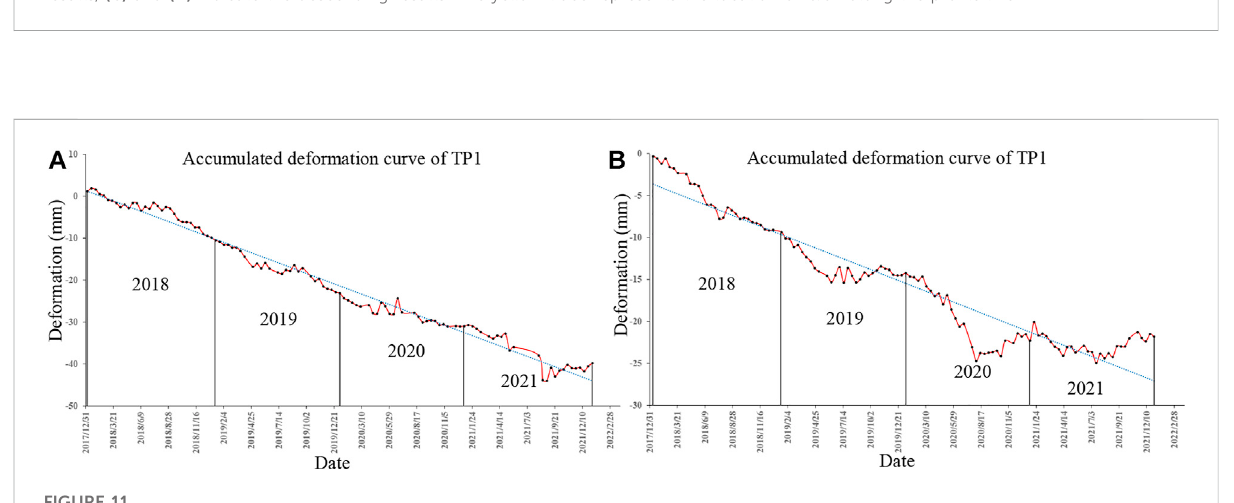
FIGURE 10 LargeversionLOSannualaveragedeformationvelocitymapfrom2018to2022ofareaD1andpro fi leline P1 . (A) and (B) indicatestheascending results, (C) and (D) indicate the descending results. The yellow trace represents the location of QGE along the pro fi le line.